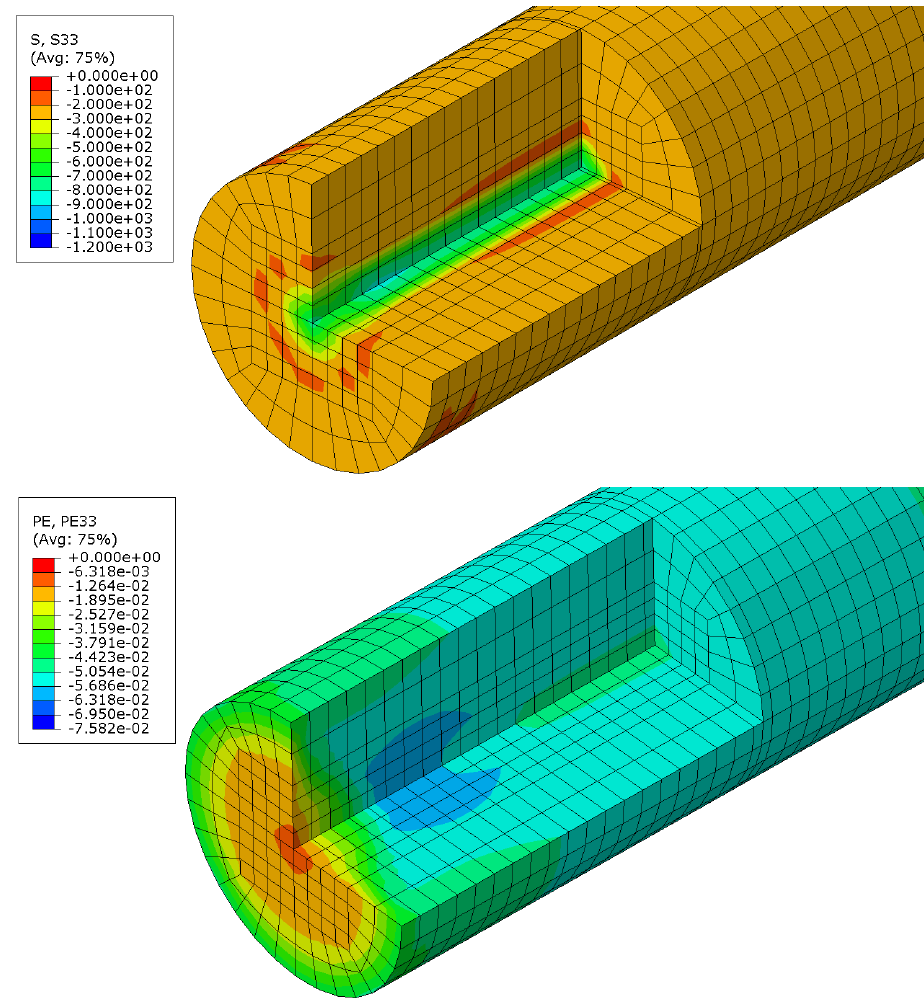
Figure 8. Contour plot of the axial stress in MPa ( top ) and the axial plastic strain ( bottom ) along a cut through the J2